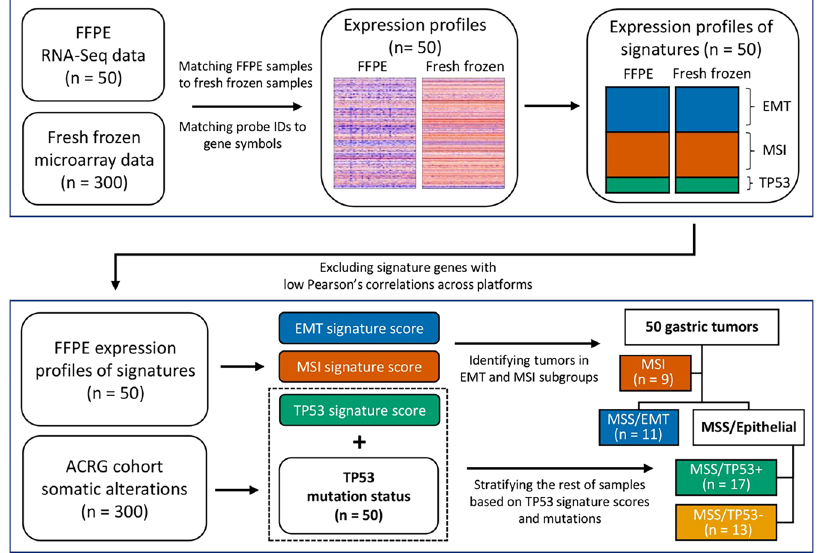
Figure 1. Analysis workflow to identify molecular subtype using 50 FFPE samples. Before subtype classification, we performed additional preprocessing, signature gene quality checks, and filtering. Next, we identified four subgroups by following a step-wise manner of ACRG